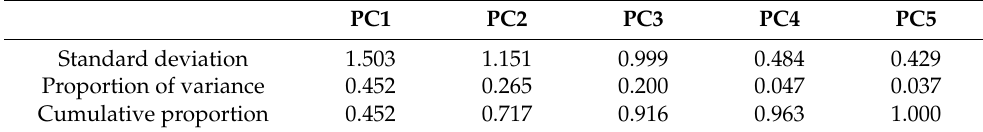
Table 16. Components’ significance.